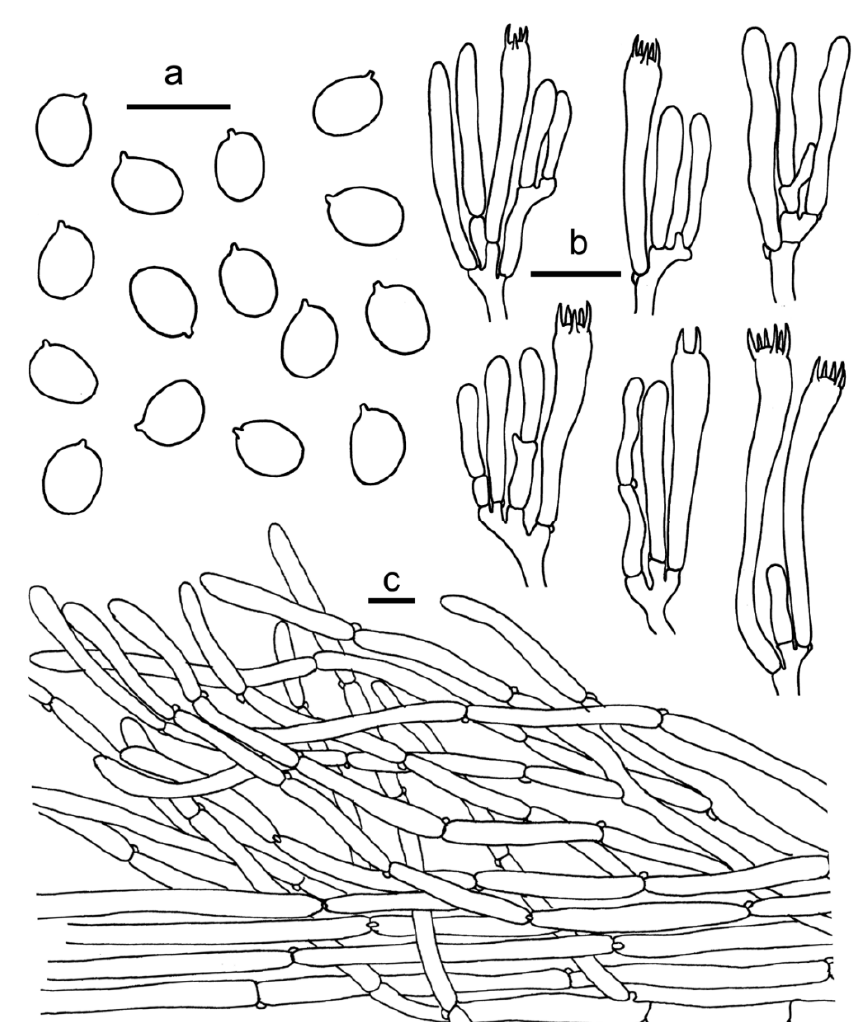
Figure 10. Cantharellus luteovirens (GDGM80672 Holotype!). ( a ) Basidiospores. ( b ) Basidia, basidiola and elements of the subhymenium. ( c ) Pileipellis. Bars: ( a , b ) = 10 μ m; ( c ) = 20 μ